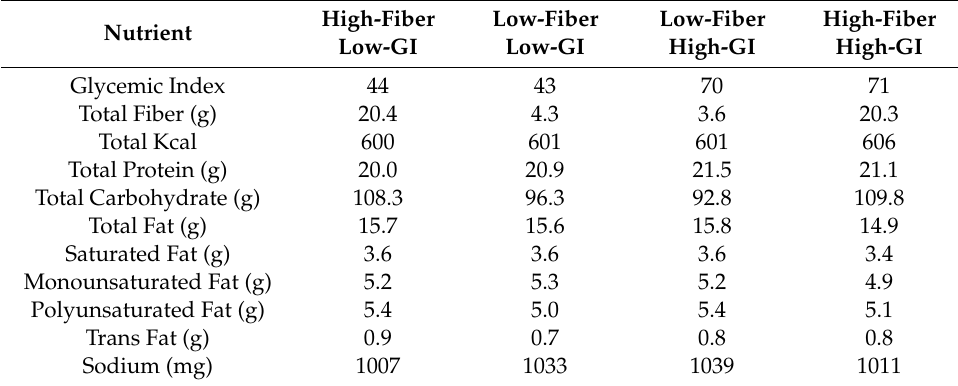
Table 1. Nutrient composition and glycemic index of the study meals.